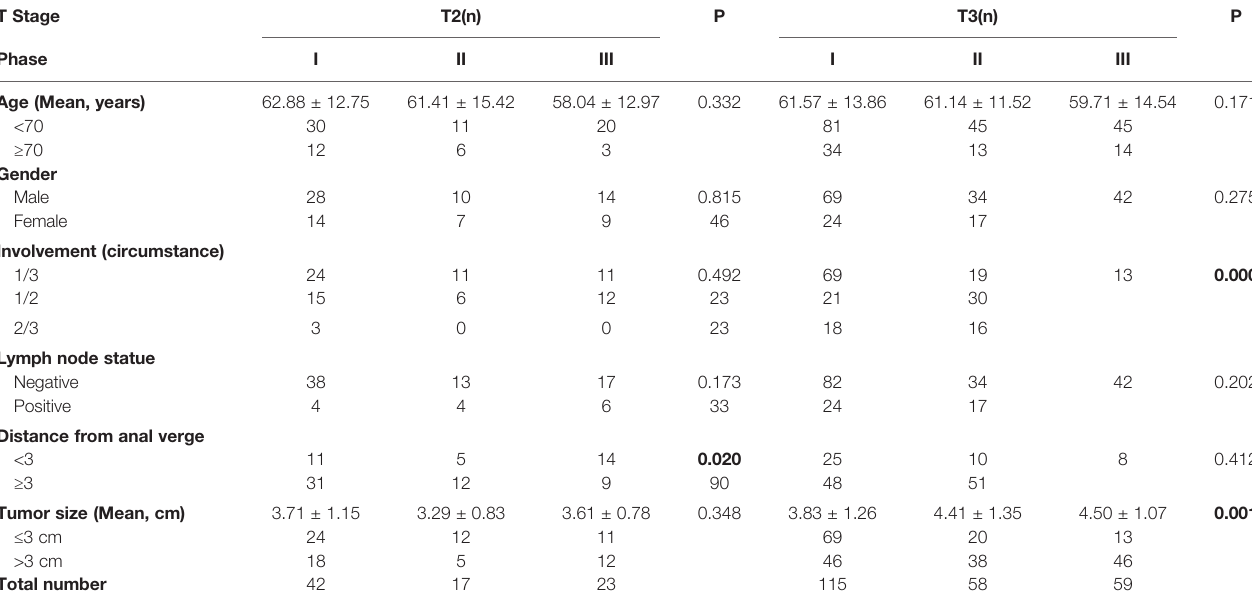
TABLE 1 | The characteristics of rectal cancer patients with T2N1M0 or T3N1M0 in phases I – III. T